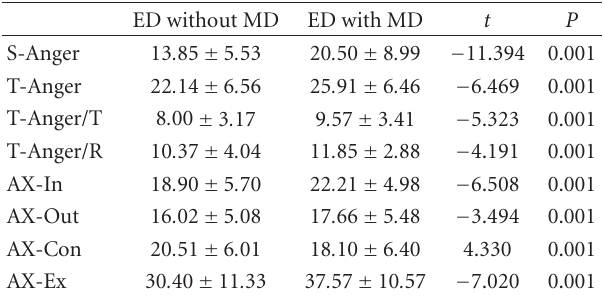
Table 1: Sociodemographic characteristics of the sample.